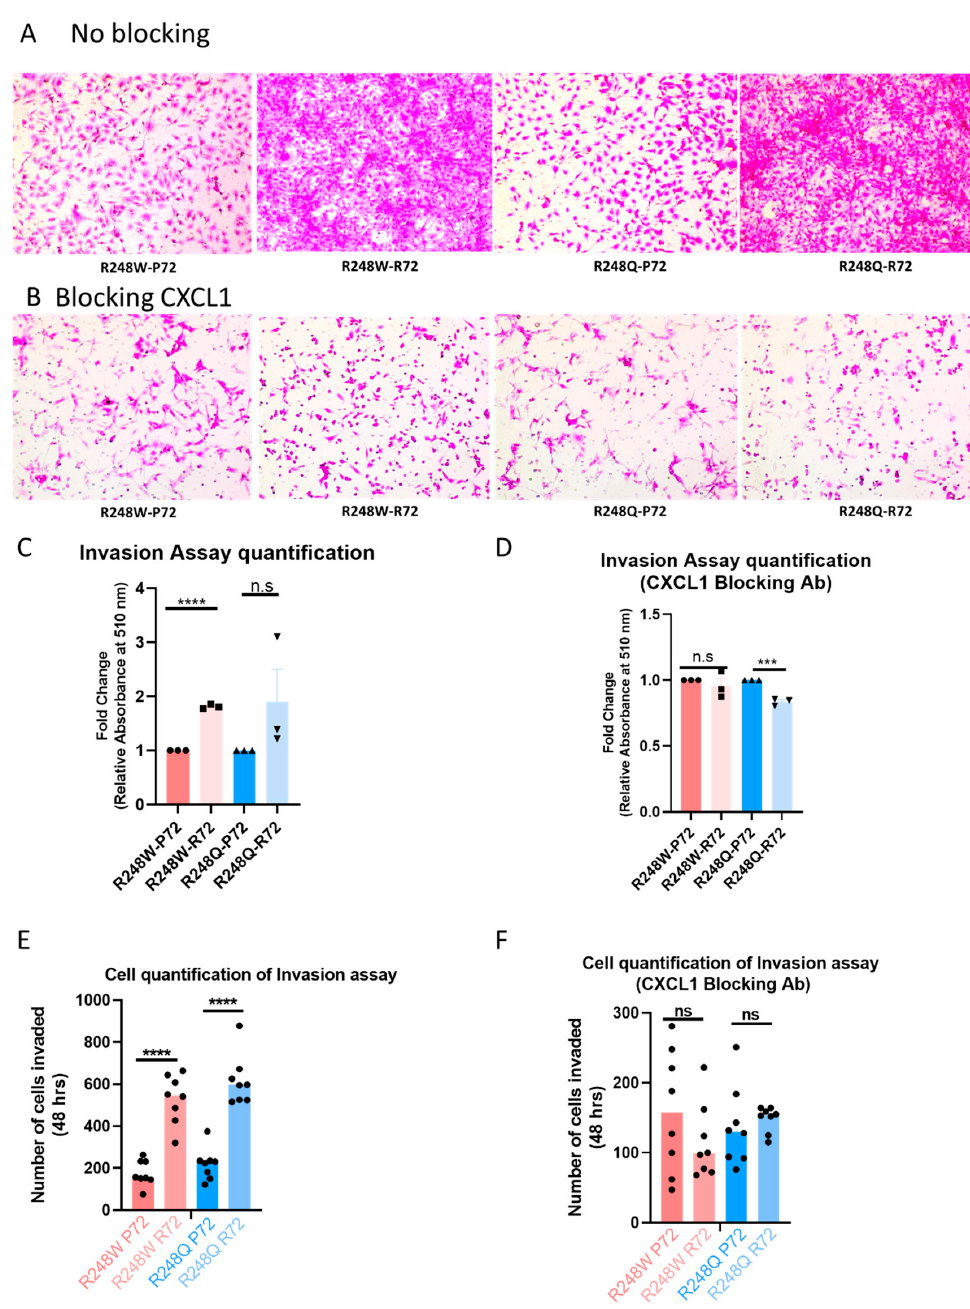
Figure 3. The P72R SNP alters the invasion profile of mutant p53 via CXCL1 ( A ) Boyden chamber transwell assay denotes invasion pattern of SKOV3 using conditioned media obtained from each of the mutants. Conditioned media was untreated with CXCL1 blocking antibody. Representative Images displayed. All images available in supplementary figures. ( B ) Boyden chamber transwell assay denotes invasion pattern of SKOV3 using conditioned media obtained from each of the mutants. Conditioned media was treated with CXCL1 blocking/neutralizing antibody (40 ng/mL). Representative Images displayed. All images available in supplementary figures. ( C , D ) Quantification of cells that were invaded by fixation followed by staining with SRB dye. Absorbance was measured at 510nm. ( E , F ) The total number of cells that invaded in 48 hrs were quantified for both mutants in eight different relicates. All data shown as mean ± SEM. The statistical analysis was performed using two-tailed Student’s t-test: *** p ≤ 0.001, **** p ≤ 0.0001.